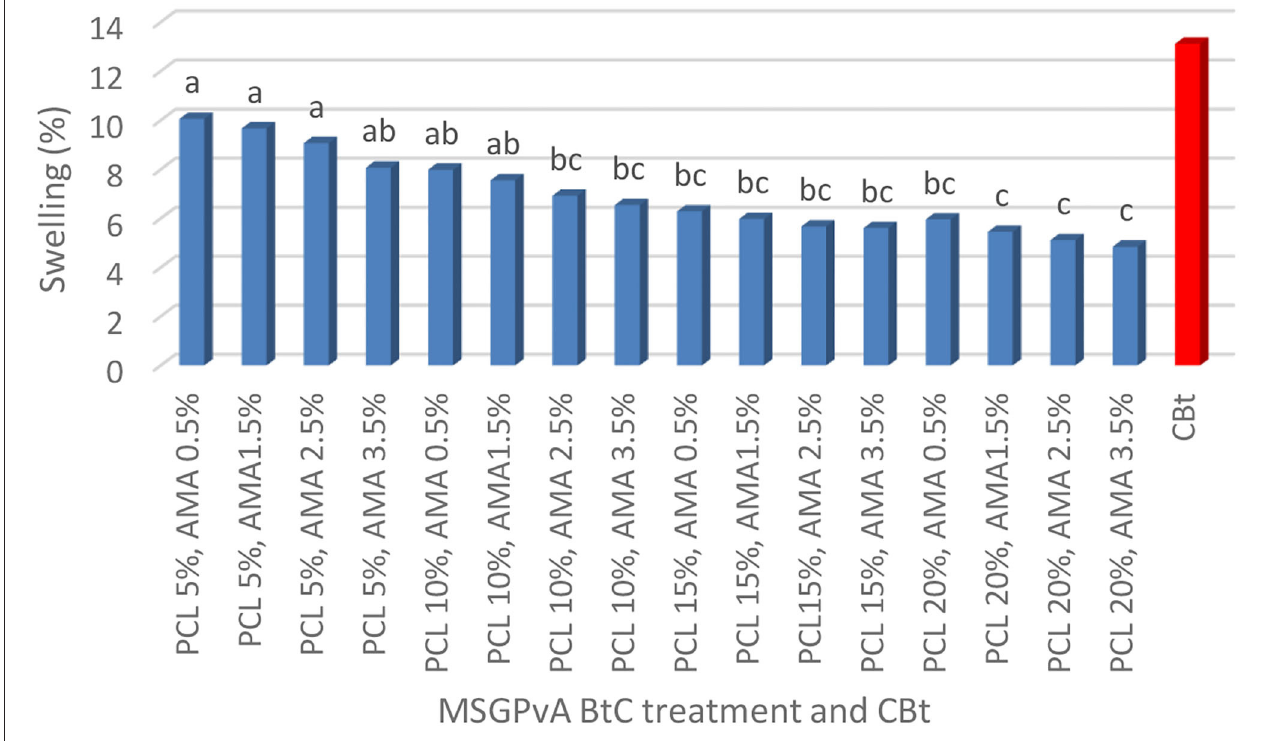
FIGURE 4 | Relationship of MSGPvA BtC and CBt with